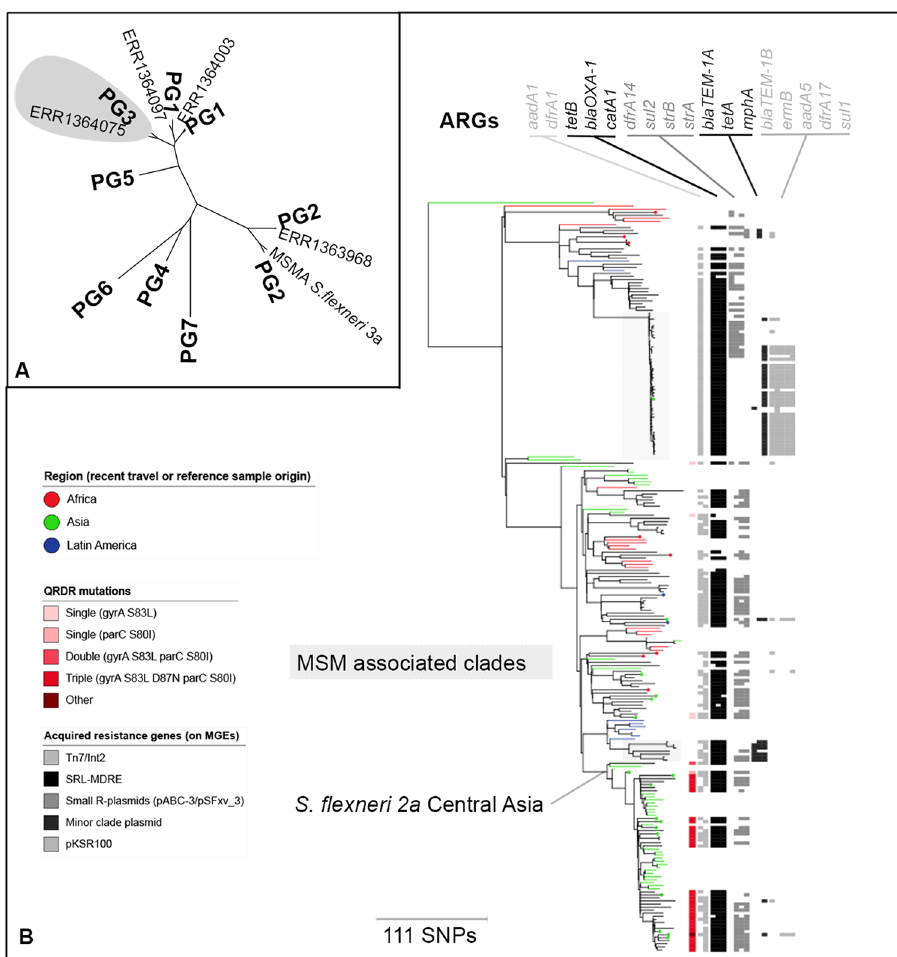
Figure 2. Shigella flexneri 2a UK cross section in context. ( A ) The smaller tree shows the broad context of phylogroups (PG) 1–7 of S . flexneri and intercontinental MSM-associated (MSMA) S . flexneri 3a, with the relationships of three non-PG3 isolates from this study. PG3 is overlaid by a grey polygon in the smaller tree and is shown in full in the larger tree. ( B ) The larger tree is a mid-point rooted maximum likelihood tree and shows the detailed evolutionary relationships of UK cross section isolates (black branches) with reference isolates (coloured branches). Reference isolate branches are coloured by region of sample origin, and region of recent travel is overlaid for UK samples as coloured circles on tree tips (both coloured according to the inlaid region key). Two MSM-associated sublineages are highlighted by grey boxes, and the S . flexneri 2a Central Asia lineage is indicated at the defining internal node. AMR features are shown in adjacent tracks. The leftmost track shows the presence of QRDR mutations and one ‘Other’, which designates a quadruple mutant also carrying the qnrS1 gene. Subsequent gray scale tracks indicate the presence of antimicrobial resistance genes (ARGs, labelled above) associated with known Shigella MGEs. Specifically (from left to right), the Tn7/Int2, SRL-MDRE, Small R-plasmids, Minor clade plasmid, pKSR100 (Table